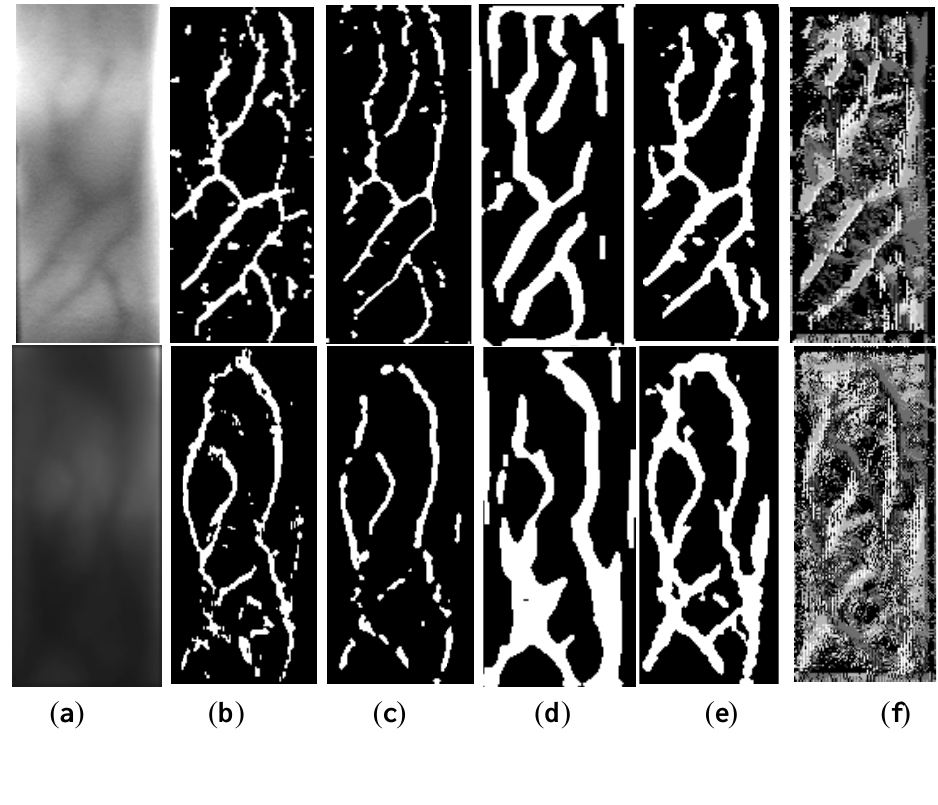
Figure 4. Sample results from different feature extraction methods: ( a ) Finger-vein images from two databases (Top left image from database A and bottom left image from database B); ( b ) Vein pattern from maximum curvature; ( c ) Vein pattern from mean curvature; ( d ) Even Gabor with Morphological; ( e ) Vein pattern from difference curvature; and ( f ) Orientation pattern from difference